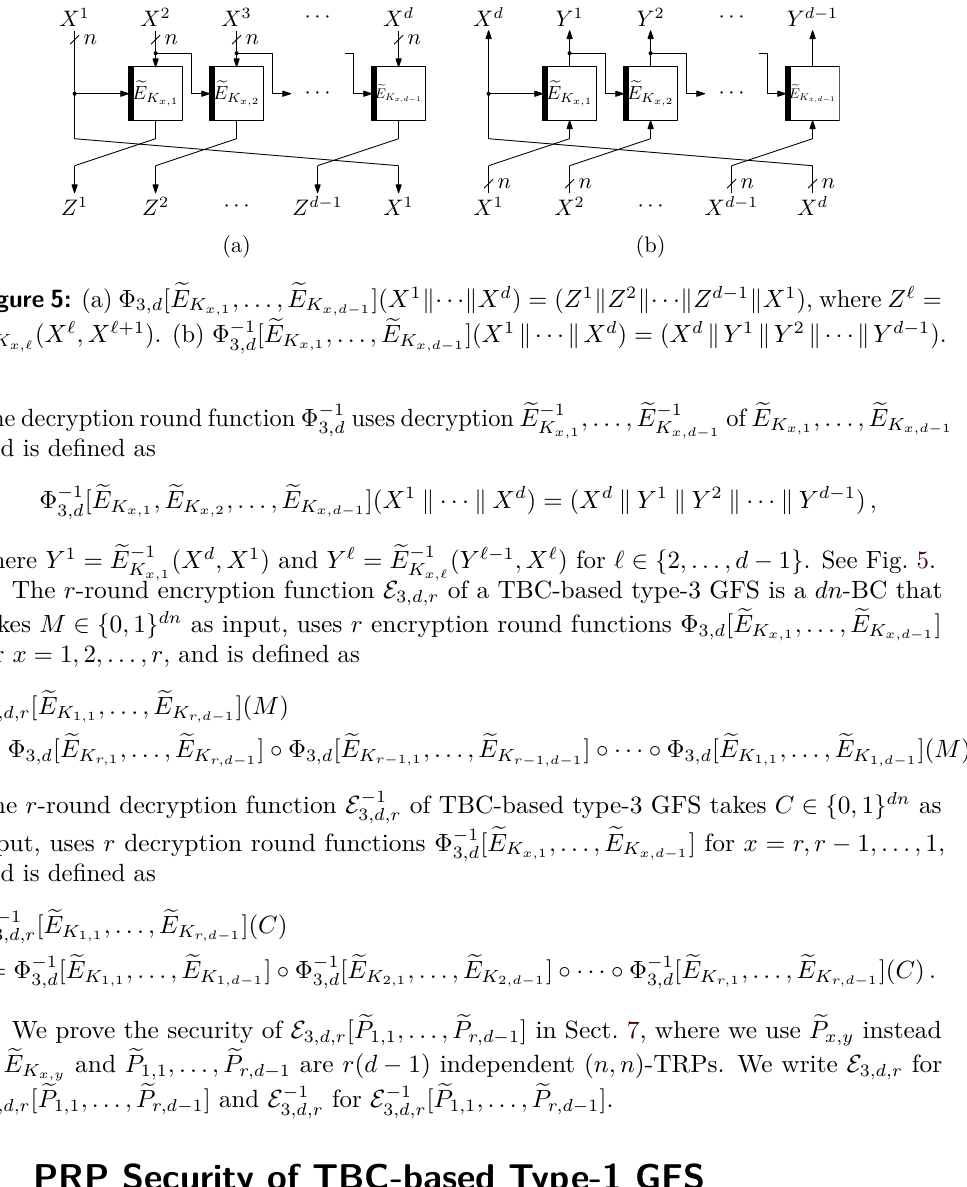
]( X 1 ∥· · ·∥ X d ) = ( Z 1 ∥ Z 2 ∥· · ·∥ Z d − 1 ∥ X 1 ), where Z ℓ , . . . , e E K x, 1 x,d − 1